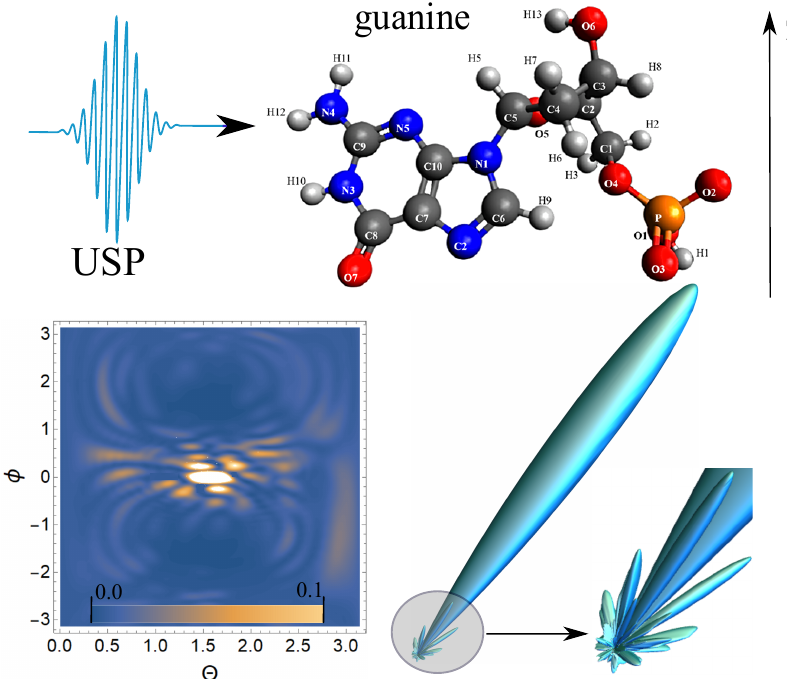
Figure 3. The spectra of USP scattering on guanine are presented. The rest is similar to Figure 2.